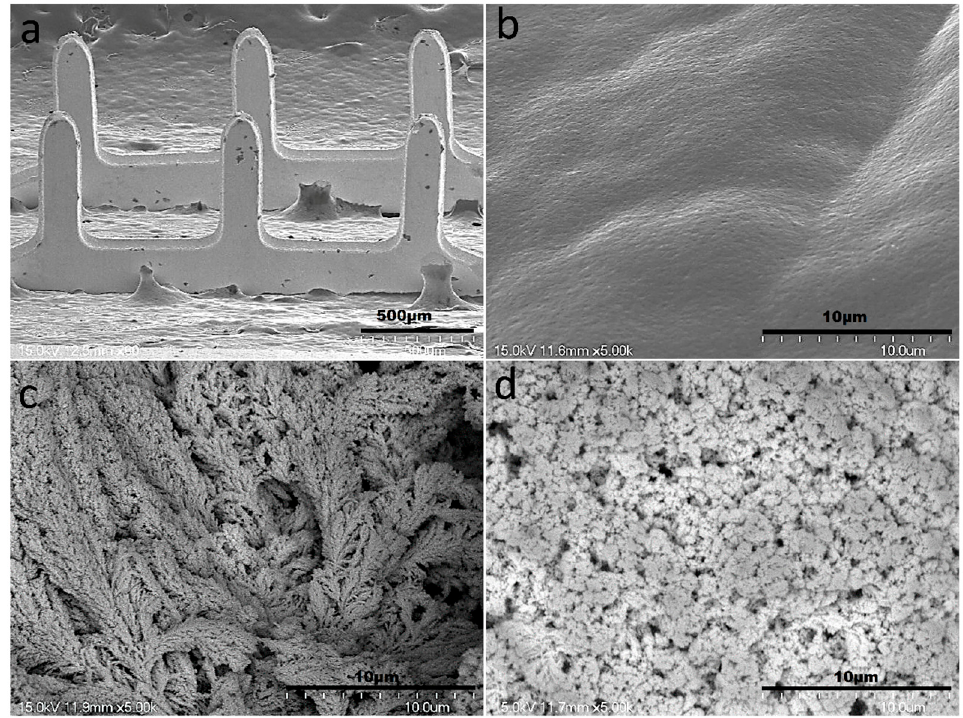
Figure 4. SEM images of the bare AuMN electrode arrays displaying an exceptional needle con- sistency ( a ); Smooth surface morphology of the bare AuMN ( b ); turning into extended branch-like structures upon Pt-black electrodeposition ( c ); and nanoporous morphology with smooth surface after packaging with the nafion polymer ( d ).